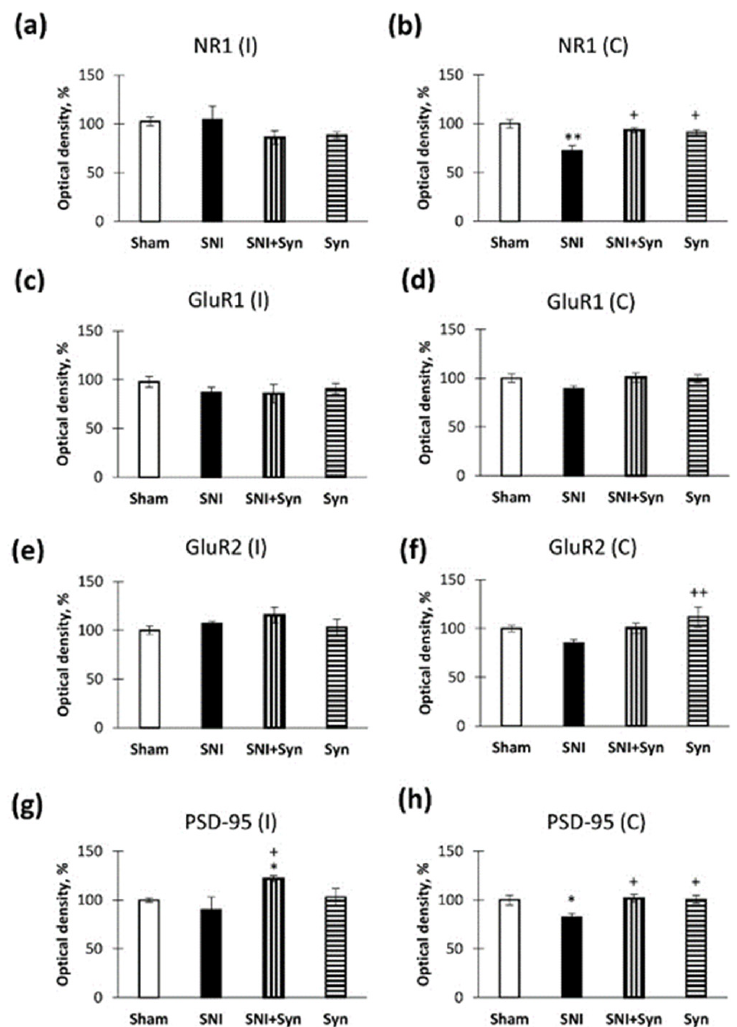
Figure 7. Neuropathic pain and treatment alter the hippocampal level of glutamate receptors and PSD-95. ( a ) Production of NMDAR1 (NR1) in ipsilateral hippocampus, optical density units, %. ( b ) Production of NMDAR1 (NR1) in contralateral hippocampus, optical density units, %. ( c ) Production of GluA1 in ipsilateral hippocampus, optical density units, %. ( d ) Production of GluA1 in contralateral hippocampus, optical density units, %. ( e ) Production of GluA2 in ipsilateral hippocampus, optical density units, %. ( f ) Production of GluA2 in contralateral hippocampus, optical density units, %. ( g ) Production of PSD-95 in ipsilateral hippocampus, optical density units, %. ( h ) Production of PSD-95 in contralateral hippocampus, optical density units, %., * p < 0.05, ** p < 0.01; + p < 0.05, ++ p < 0.01. *-compared to Veh, + -compared to LPS.